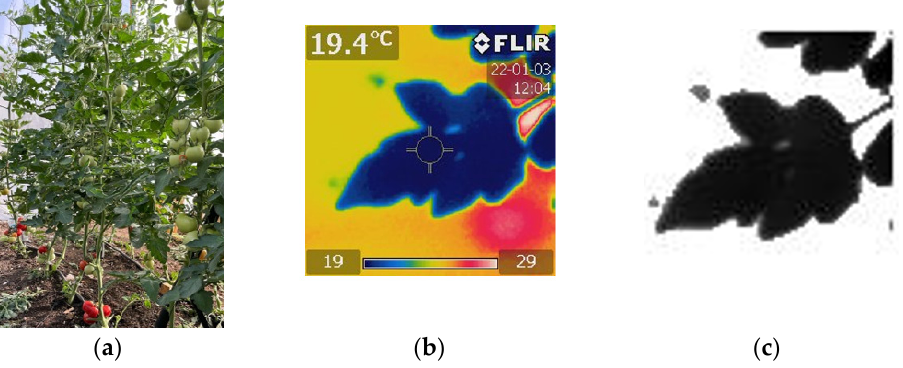
Figure 1. Images of a tomato plant and leaf: ( a ) leaves exposed to incoming solar radiation at multiple sections of a plant and different directions, ( b ) thermal image, ( c ) processed thermal